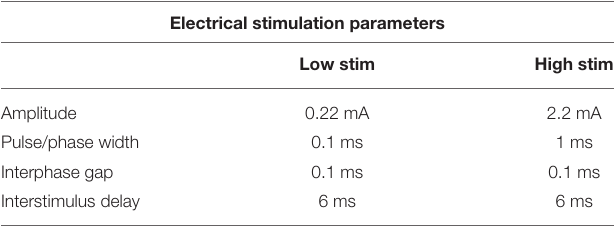
TABLE 1 | Electrical stimulation parameters